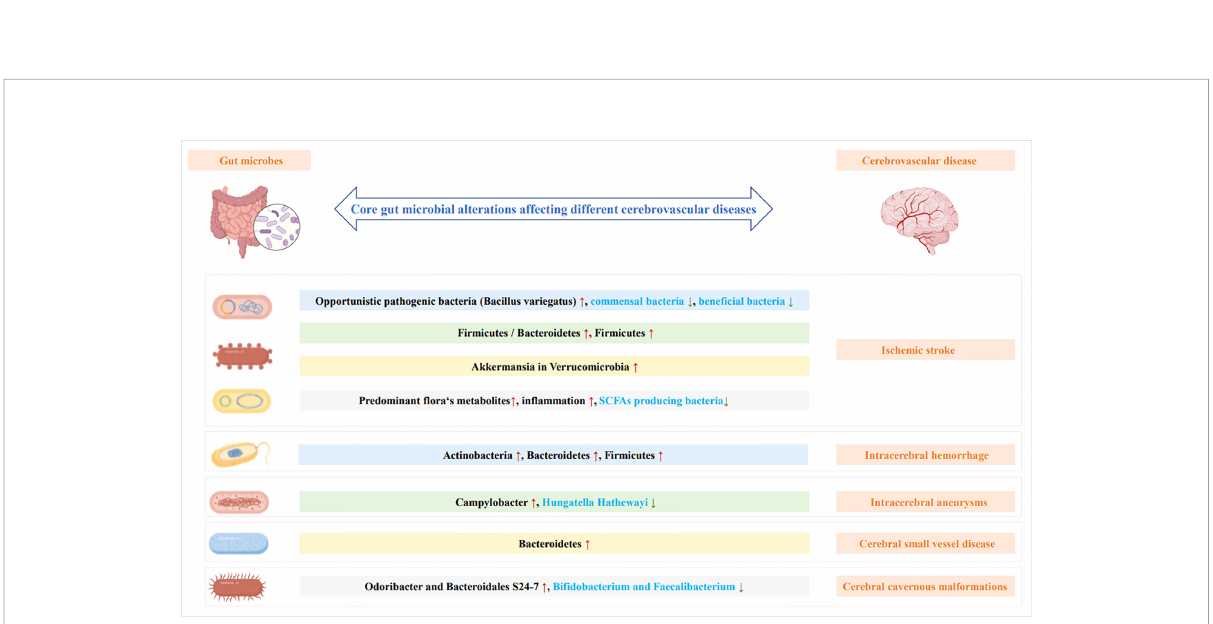
FIGURE 3 The change in core gut microbes in fl uences different cerebrovascular diseases.